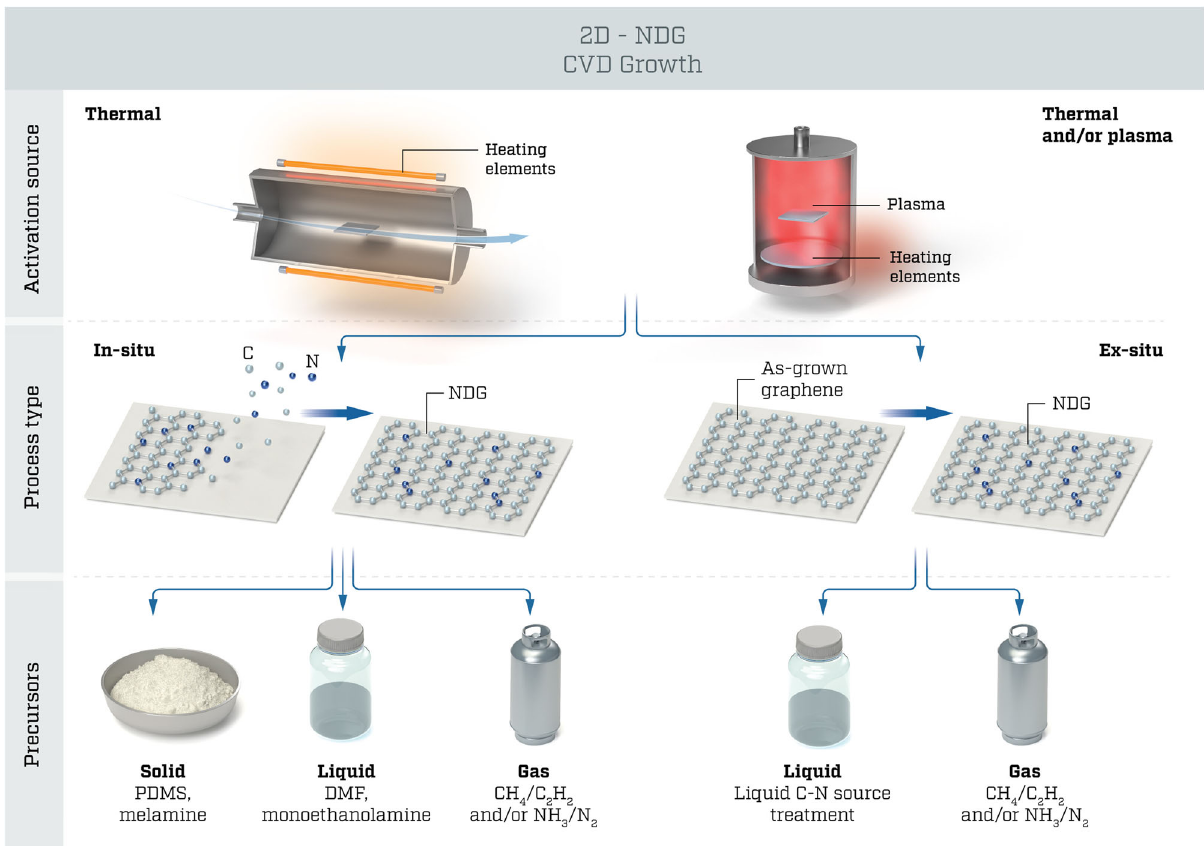
Fig. 2 Tree diagram of NDG growth via different CVD approaches categorized by type. (1) activation source (thermal, plasma, or both), (2) type of process (in situ or ex situ), and (3) source material type (solid, liquid, or